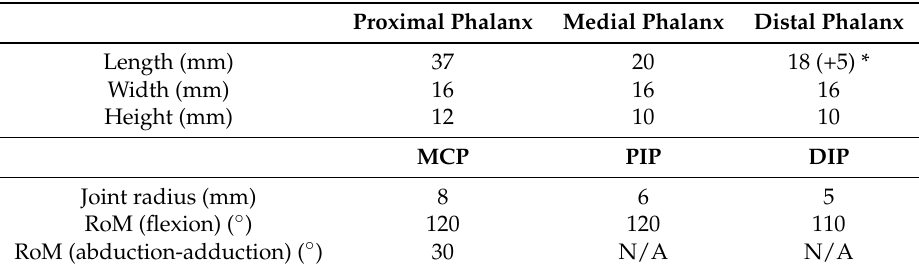
Table 4. Dimensions of the dummy finger and its range of motion.